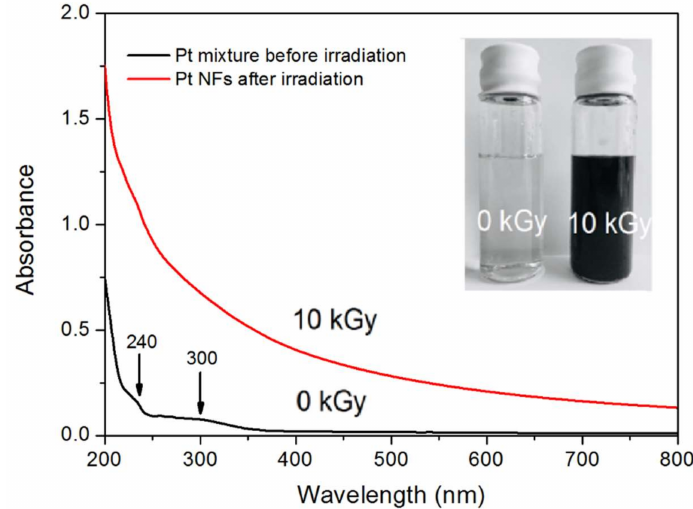
Figure 1. UV-Vis absorption spectra of diluted Pt containing solutions (10 − 3 mol L − 1) before (black line) and after (red line) irradiation (optical path = 2 mm). Inserts: images of solutions resulting from 0 and 10 kGy radiation